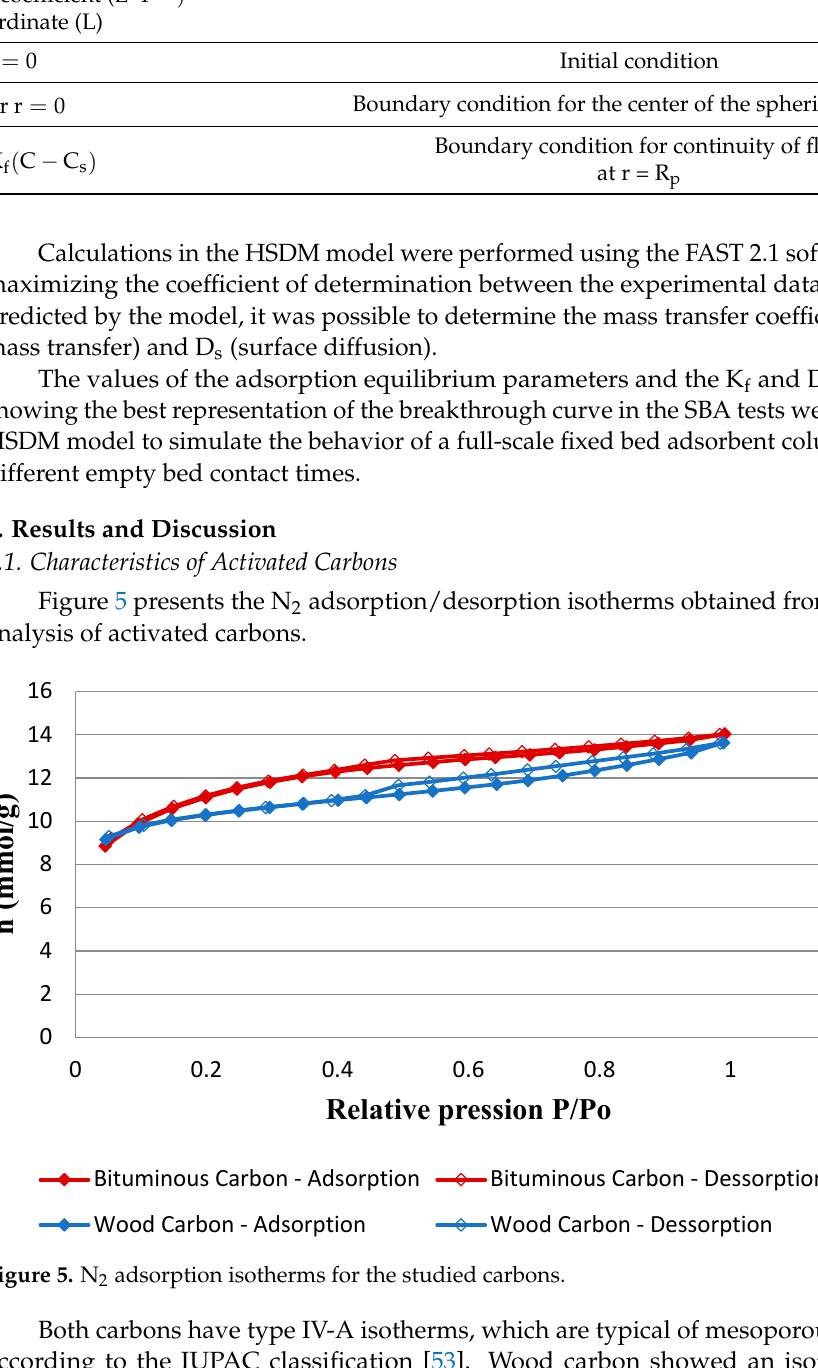
Table 3. Physical characteristics of the studied carbons.